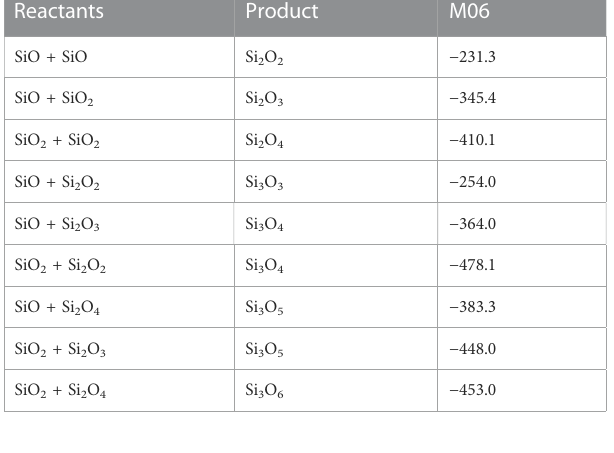
TABLE 1 Reaction energies of clustering reactions calculated using M06/maug- cc-pV(T+d)Z calculations. The energies (at T = 0 K) are given in kJ/mol relative to the respective reactants and include zero-point energy corrections.